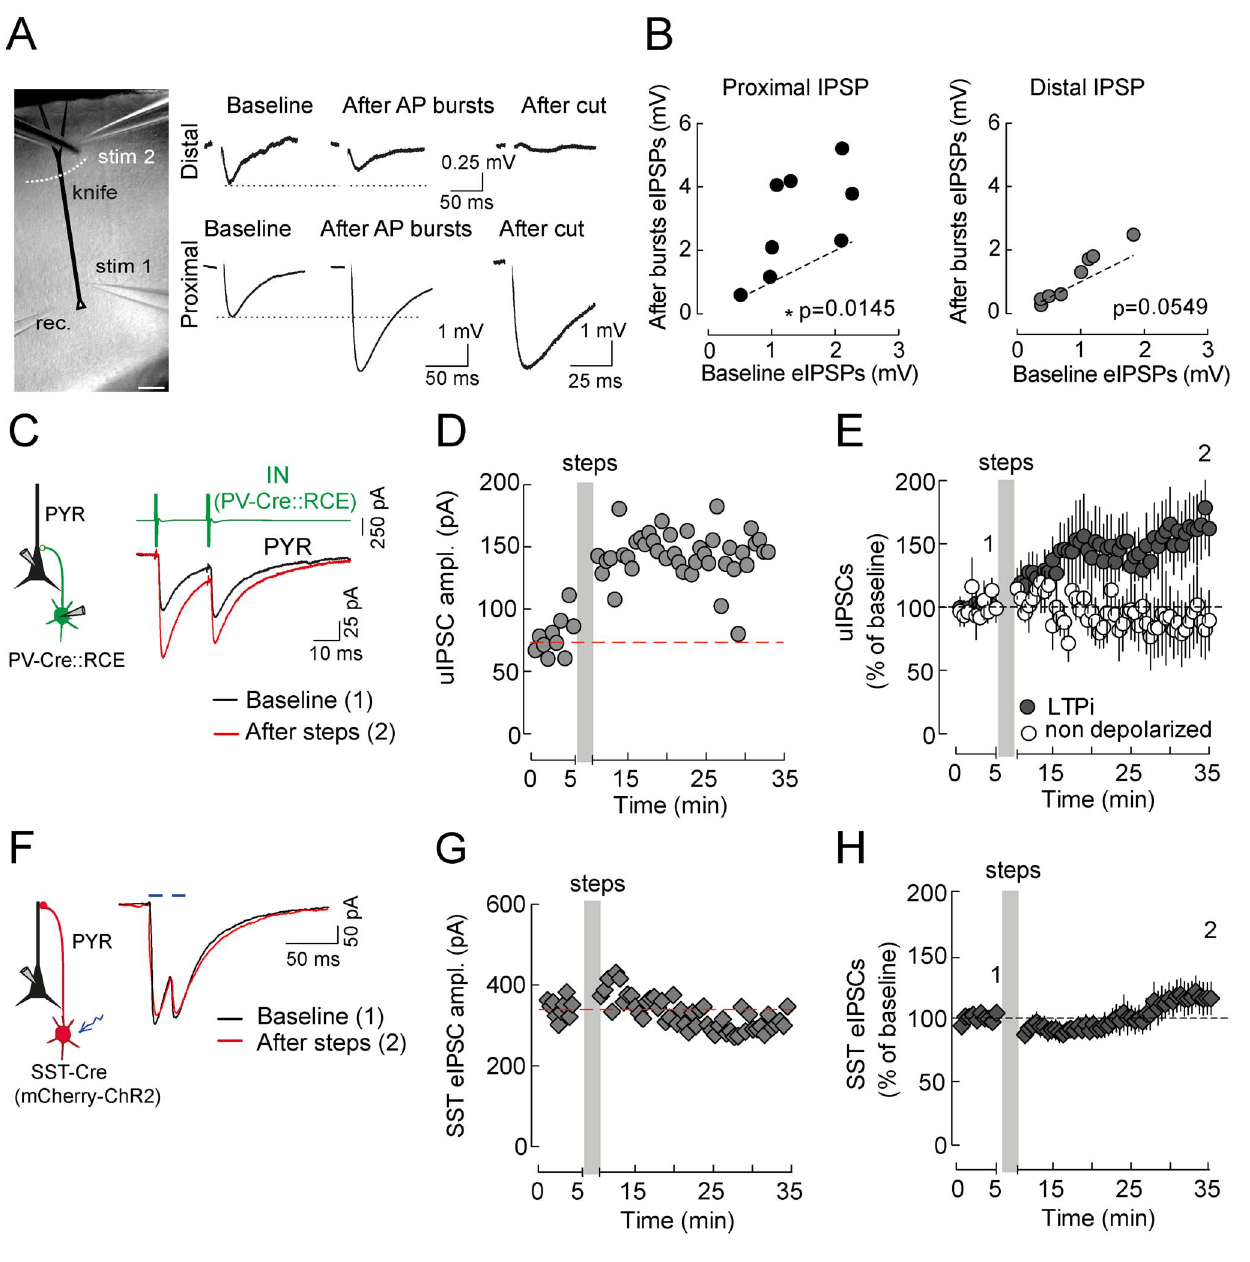
Figure 3. LTPi is selectively expressed at perisomatic GABAergic synapses from PV cell. (A, Left) Micrograph showing recording and stimulating configurations. The dashed white line schematizes the cut by a fourth broken glass pipette. (A, Right Top) Representative current-clamp traces of distally evoked eIPSPs before, after AP bursts (5 APs at 100 Hz, repeated 15 6 ) and after cut. (A, Right Bottom) Representative traces of proximally evoked eIPSPs in the same conditions. (B) Plots of proximal (Left) and distal (Right) IPSP amplitudes in control versus 20 min after LTPi- inducing AP bursts. (C, Left) Schematic of simultaneous paired recordings from a presynaptic PV basket cell and a postsynaptic layer 5 pyramidal neuron. PV cells were identified as expressing EGFP in PV-Cre::RCE mice (see Materials and Methods) [18]. (C, Right) Action currents in voltage clamp (green) in the presynaptic interneuron (IN) trigger uIPSCs in the postsynaptic pyramidal neuron (PYR). Black trace, before the depolarizing steps; red trace, after induction of d-LTPi. (D) Time course of the cell of (C), showing a persistent increase of uIPSCs after postsynaptic depolarizing steps (grey area). (E) Population data of paired recordings, showing LTPi when the postsynaptic cell was depolarized (filled symbols) and absence of plasticity when pyramidal neurons were not depolarized. Data are single values and/or mean 6 SEM. * p , 0.05. (F) Schematic of optogenetic activation of SST- positive interneurons. ChR2 was co-expressed with mCherry in SST-cre mice using viral vectors (see Materials and Methods) [20]. (F, Right) Brief (2 ms) flashes of 470 nm light (blue bars) induced a GABAergic current that was insensitive to LTPi-inducing protocols (black trace, control; red trace, after postsynaptic depolarizing steps). (G) Time course of the cell of (F), showing lack of persistent increase of SST-mediated population IPSCs after postsynaptic depolarizing steps (grey area). (H) Population data of SST-mediated population IPSCs, showing lack of LTPi when the postsynaptic cell was depolarized. Numbers (1 and 2) refer to times of trace illustration.